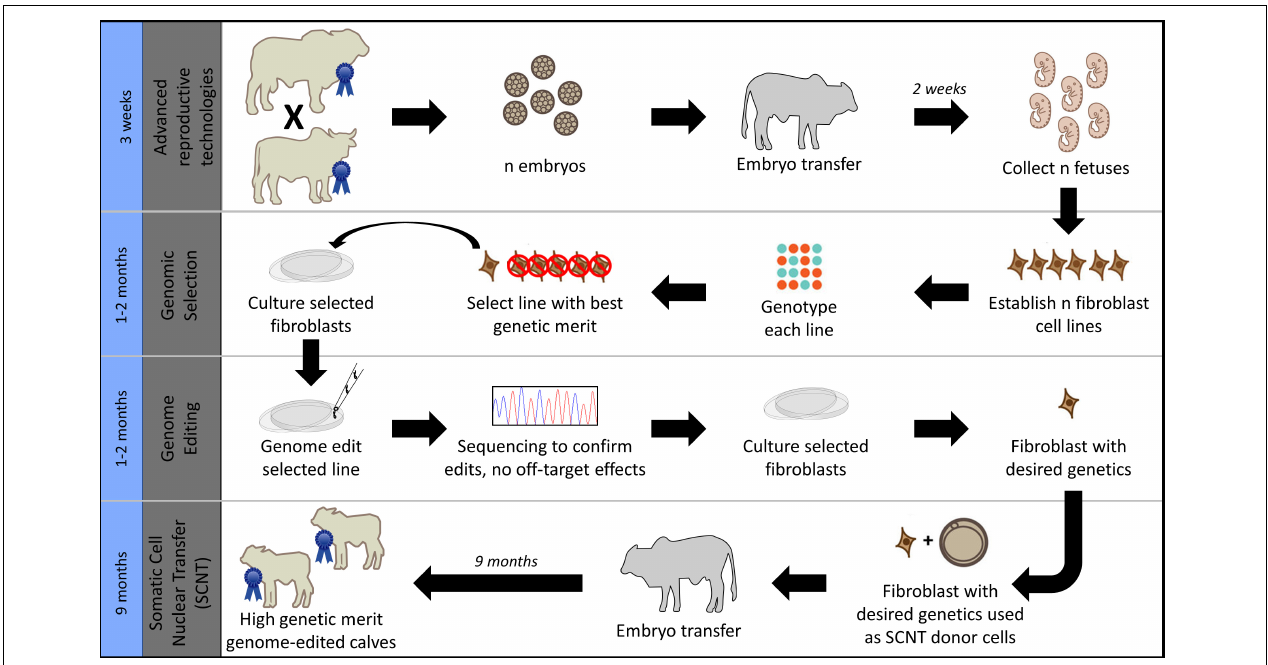
FIGURE 1 | Gene editing was modeled as an added step to the elite sire production system proposed by Kasinathan et al. (2015), which combines the use of advanced reproductive technologies and somatic cell nuclear transfer cloning (SCNT) with embryo transfer (ET). Image modified from Van Eenennaam (2017) used with